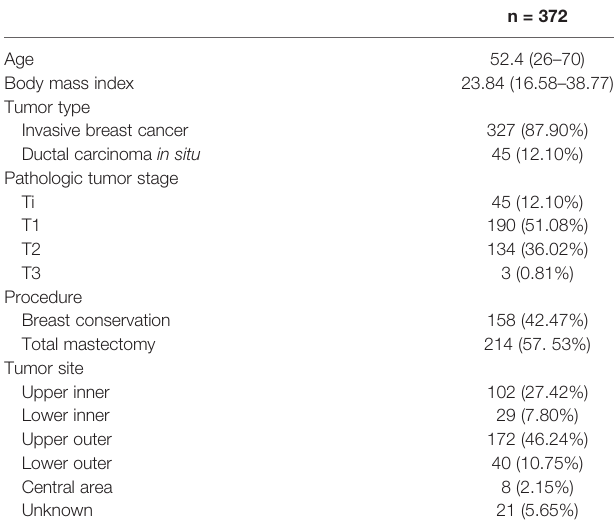
TABLE 1 | General patient characteristics.